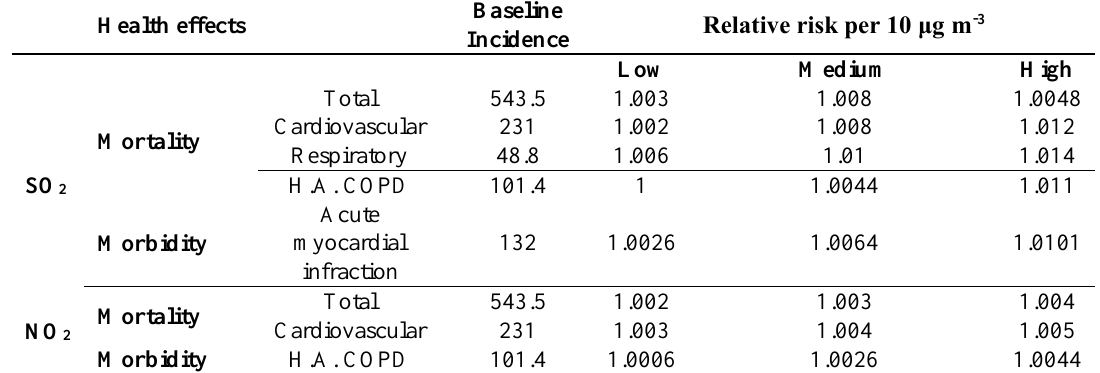
Table 3 Relative risk with 95% CI and corresponding reference, implemented by Air quality software and used for